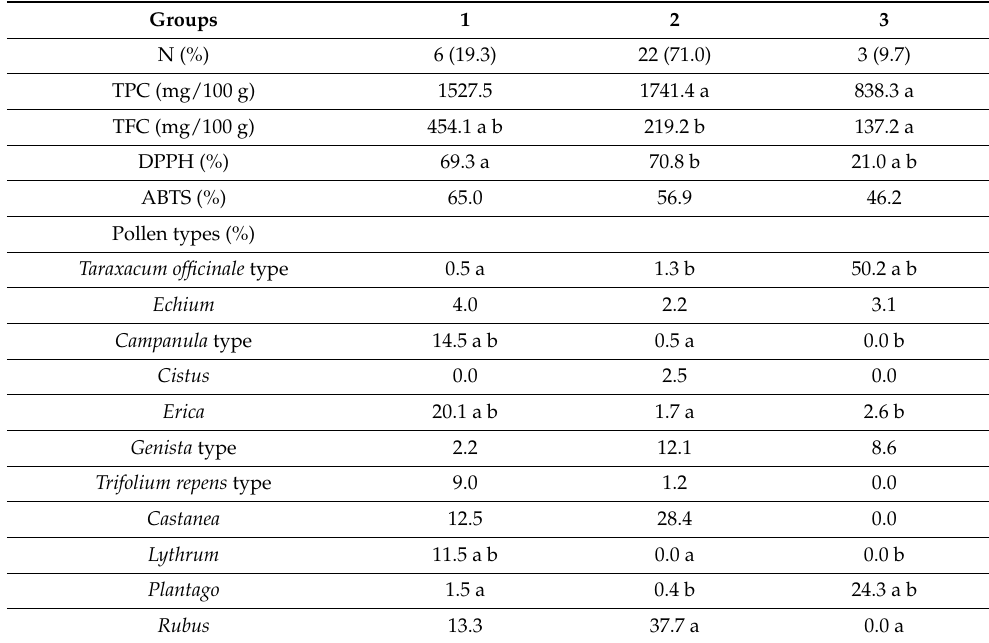
Table 4. Groups of bee pollen samples of each class obtained by the cluster